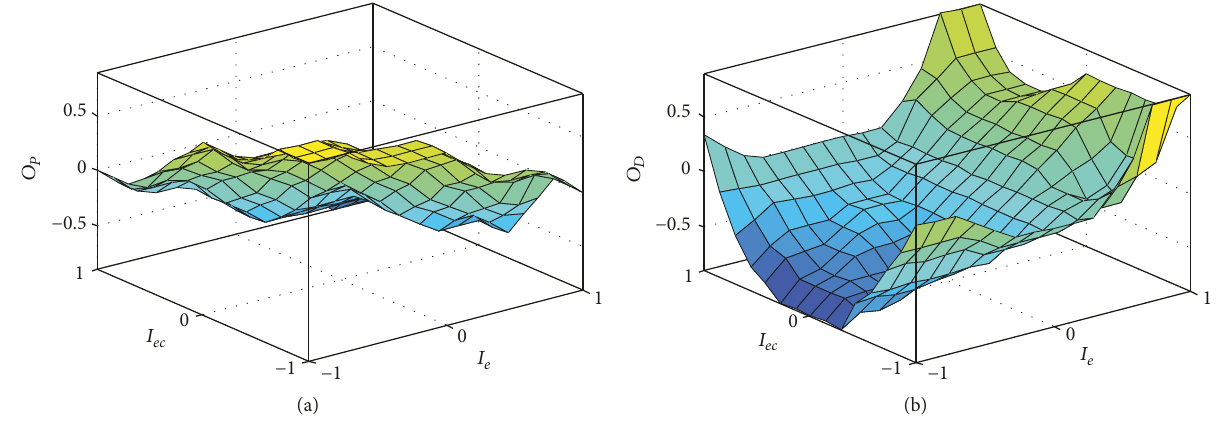
Figure 2: The surface views of fuzzy inference rules on Δ 𝐾𝑃 (a) and Δ 𝐾𝐷